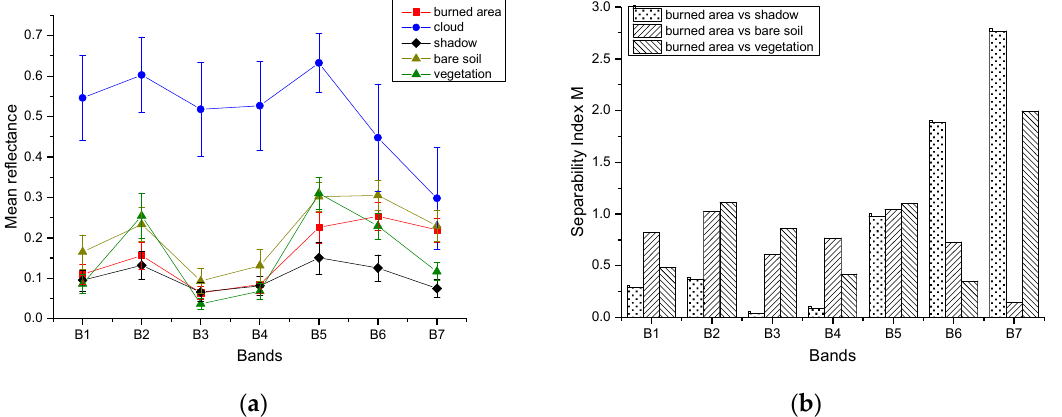
Figure 6. ( a ) Reflectance curve of the five typical types extracted from Hot Pot Fire; ( b ) separability index M of the three comparisons: burned area vs. shadow, burned area vs. bare soil, burned area vs. vegetation.